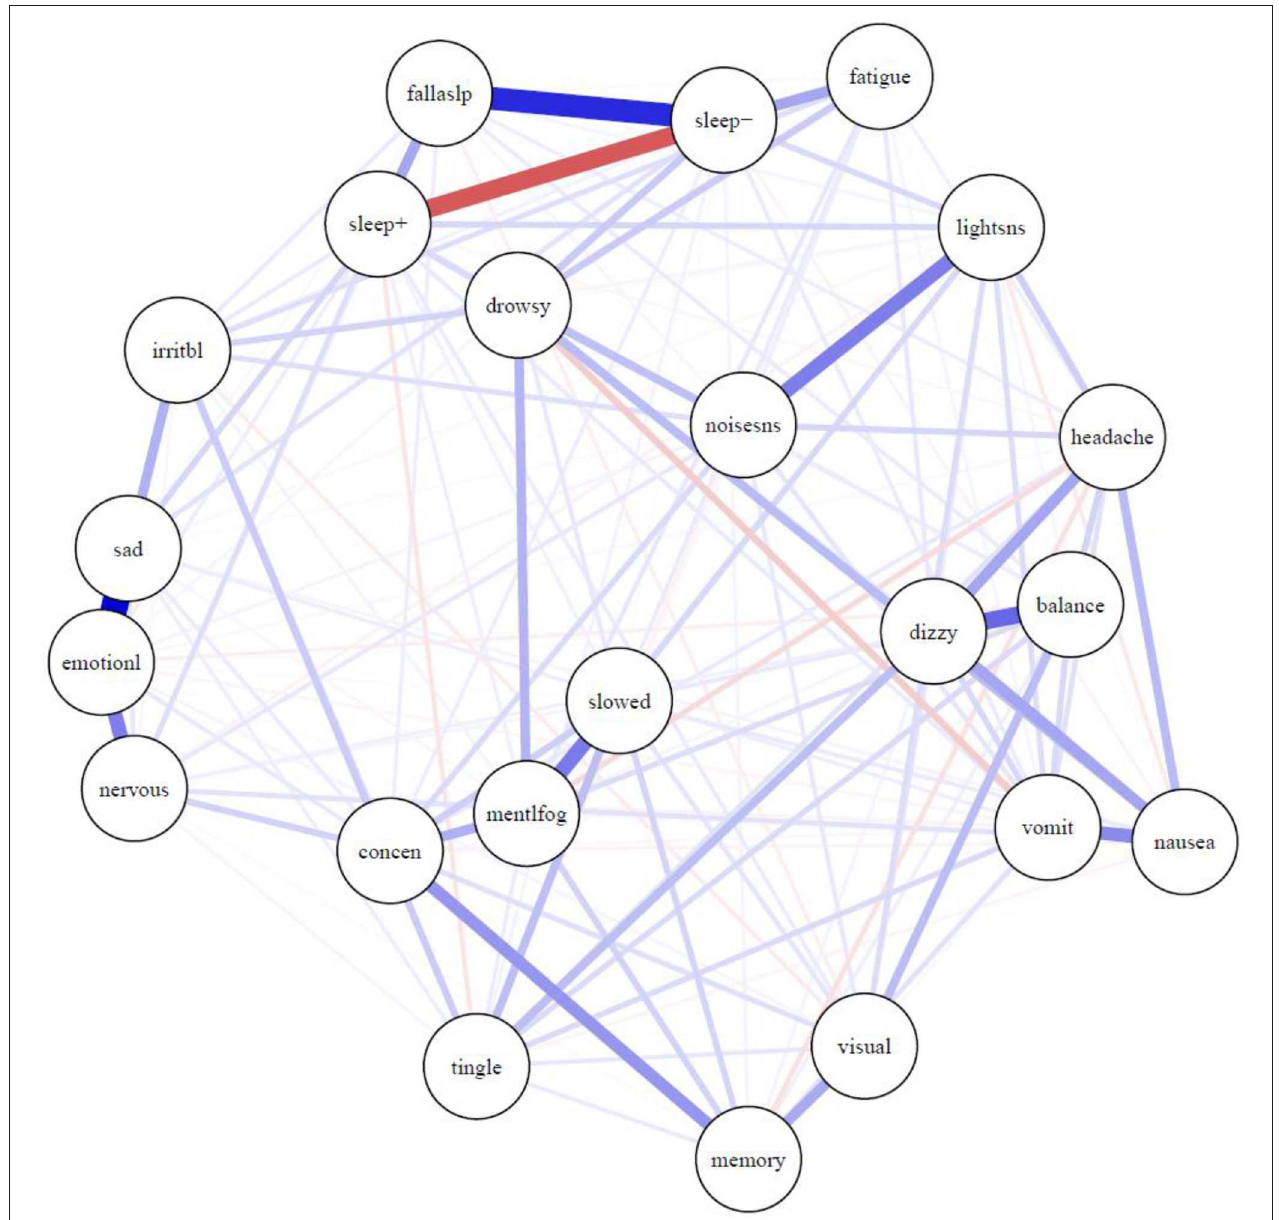
FIGURE 1 | Network of symptoms during preseason baseline testing in student athletes with a history of mental health problems. Symptoms: balance, balance problems; concen, difficulty concentrating; dizzy, dizziness; drowsy, drowsiness; emotionl, feeling more emotional; fallaslp, trouble falling asleep; fatigue, fatigue; headache, headache; irritbl, irritability; lightsns, light sensitivity; memory, difficulty remembering; mentlfog, mentally foggy; nausea, nausea; nervous, nervousness; noisesns, noise sensitivity; sad, sadness; sleep-, sleeping less than usual; sleep + , sleeping more than usual; slowed, feeling slowed down; tingle, numbness and tingling; visual, visual problems; vomit,